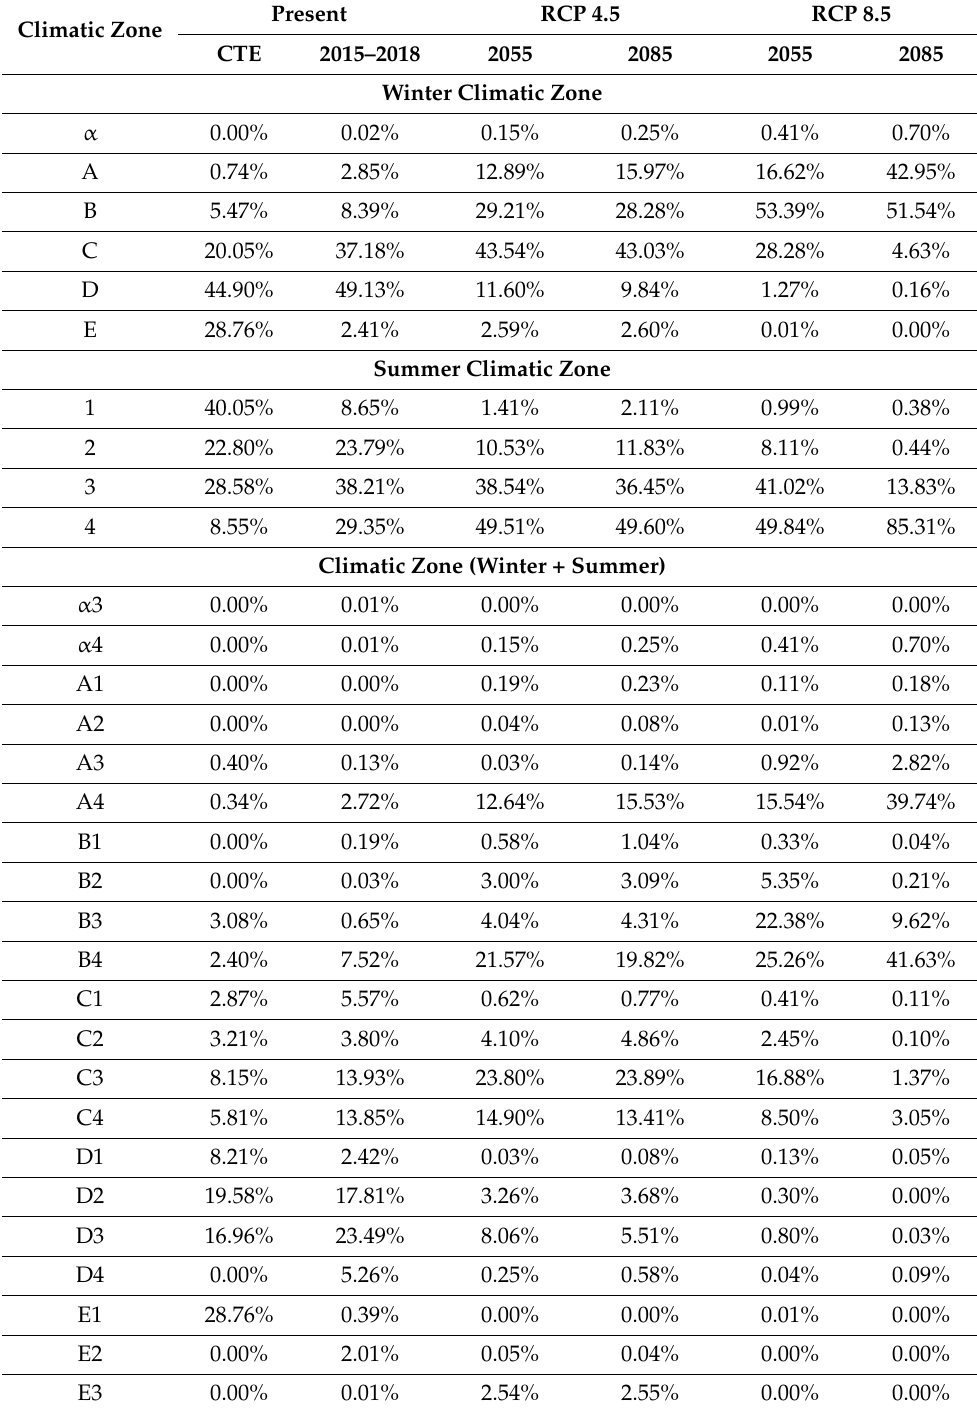
Table 4. Percentage of climate zones in different